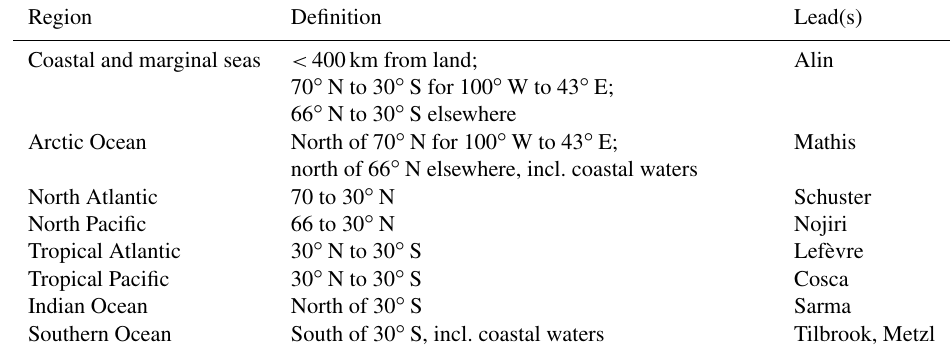
Table 4. Regions with their leads in version 3 (after Bakker et al., 2014). The regions are the same as in version 2. Region